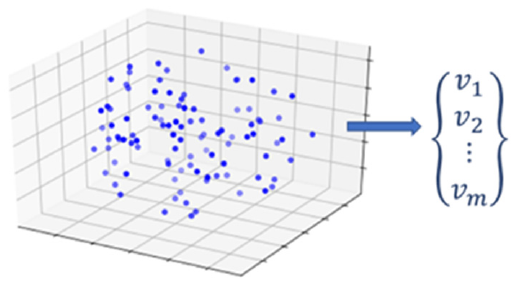
Figure 3. Feature extraction of convex hull vertices from a three-dimensional (3D) point cloud.